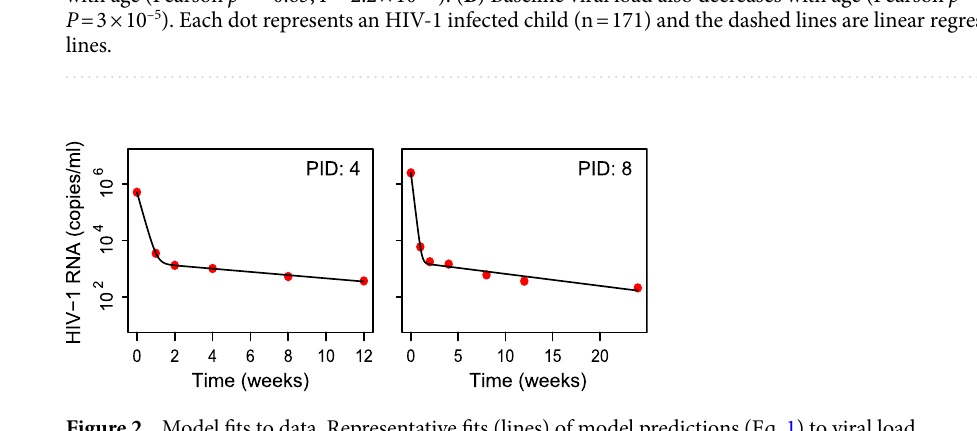
Figure 2. Model fits to data. Representative fits (lines) of model predictions (Eq. 1) to viral load measurements(symbols) in two HIV-1 infected children following the onset of cART. Fits to data from other children are shown in Fig. S1. The best-fit parameter estimates are in Table